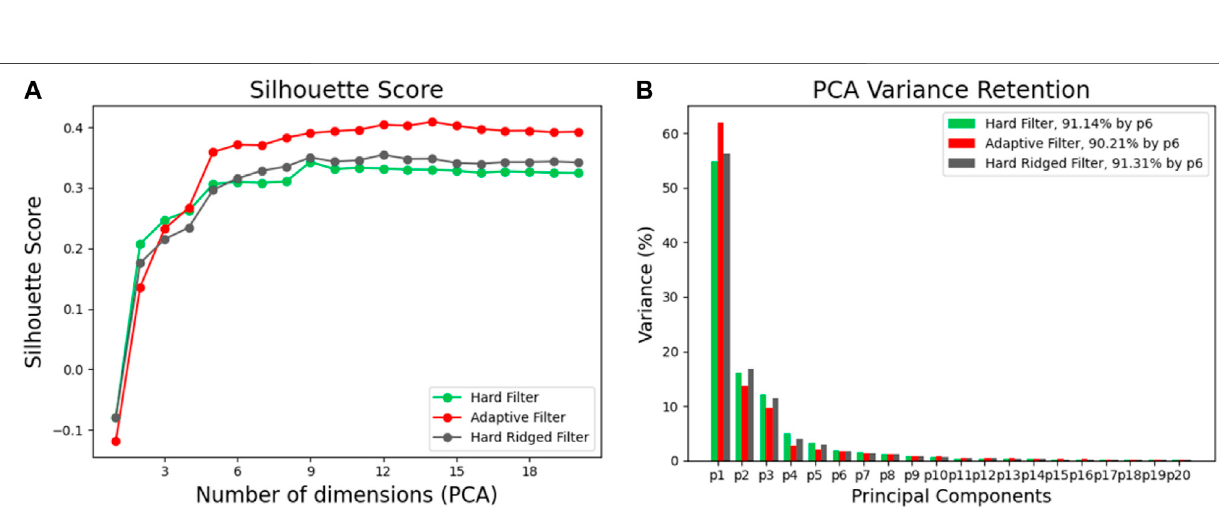
Frontiers in Robotics and AI |